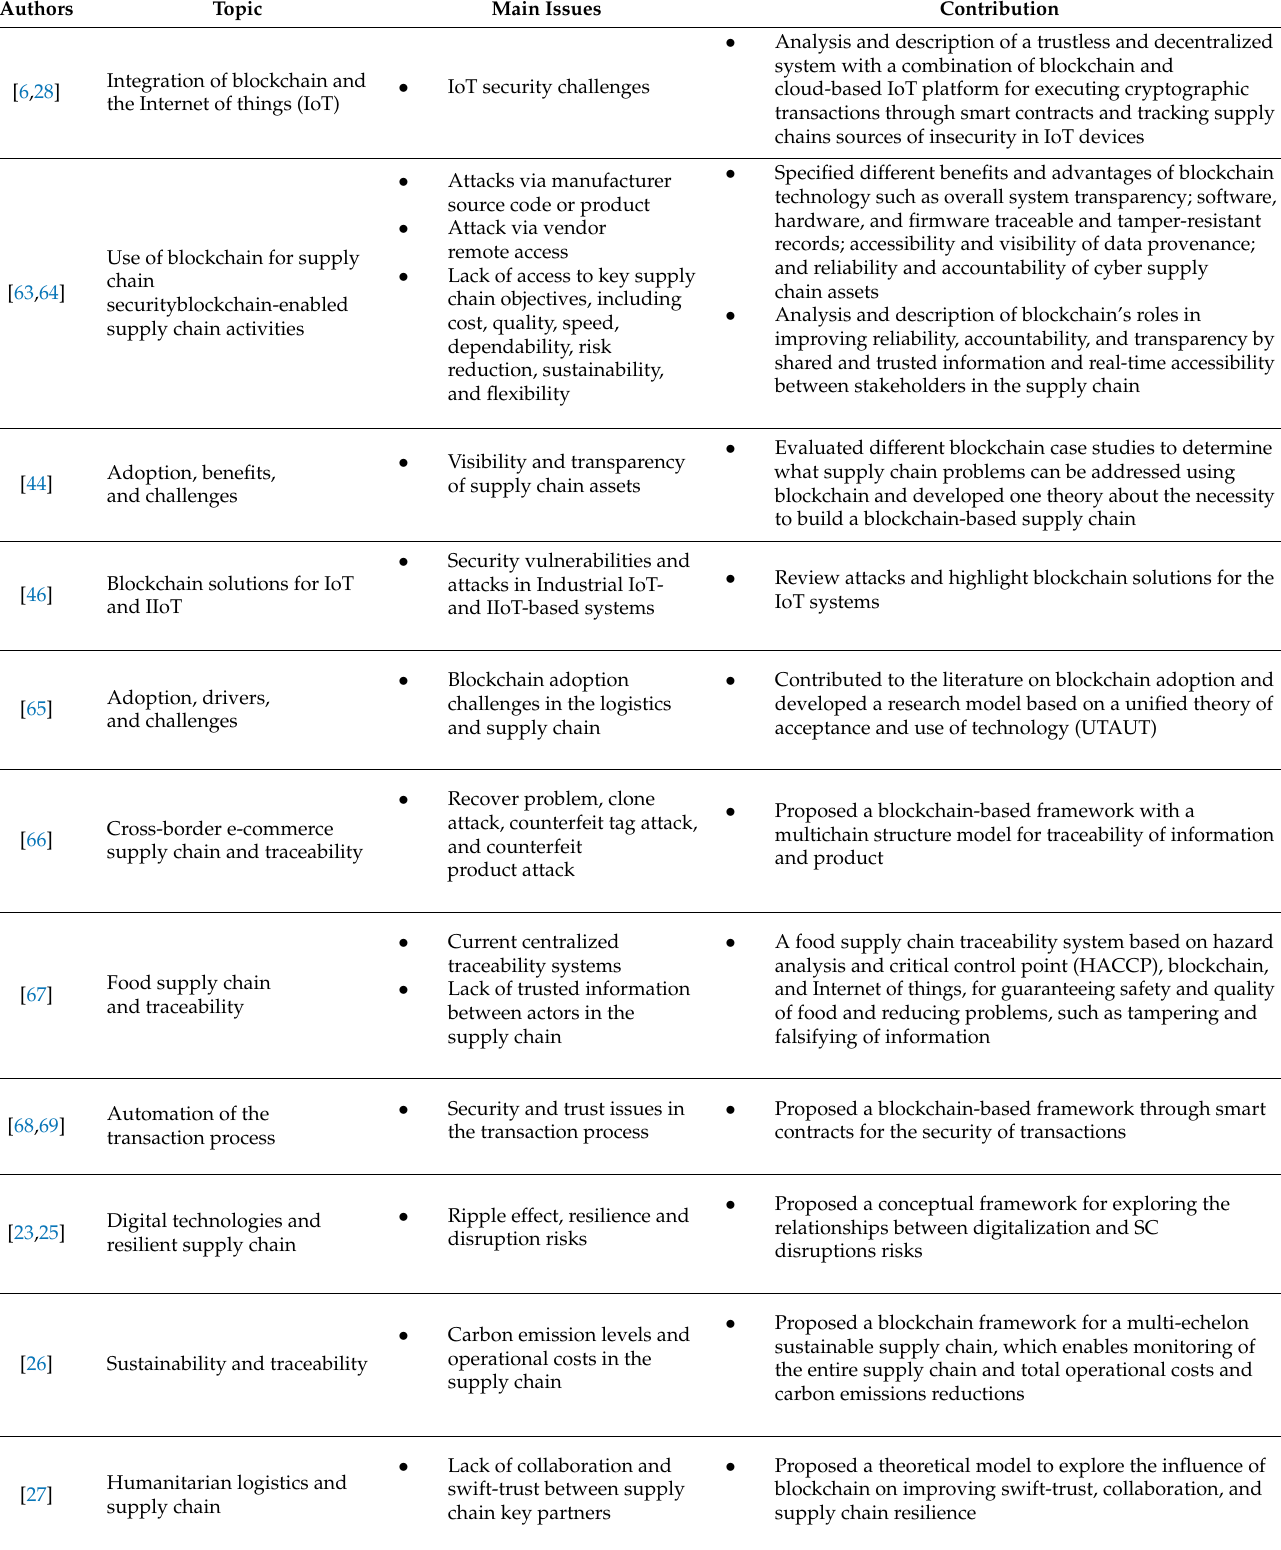
Table 1. Analysis of the most relevant documents belonging to the main